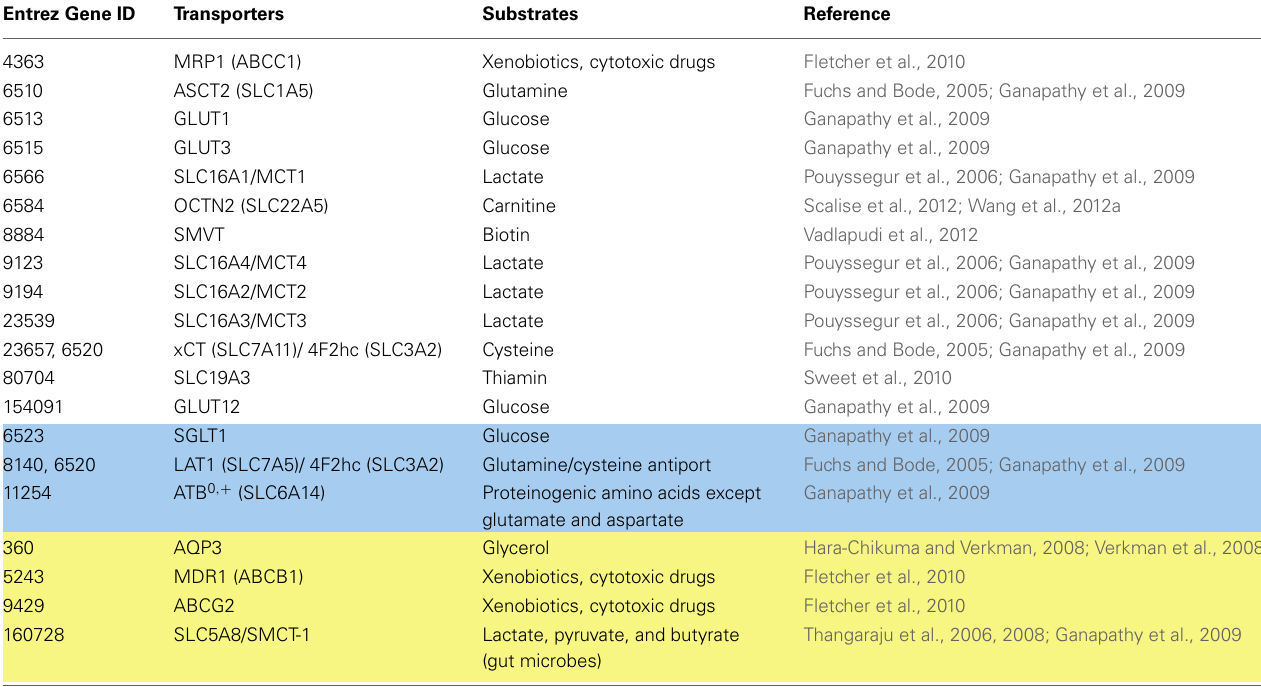
Table 5 | Metabolite transporters relevant to cancer and their current coverage in Recon